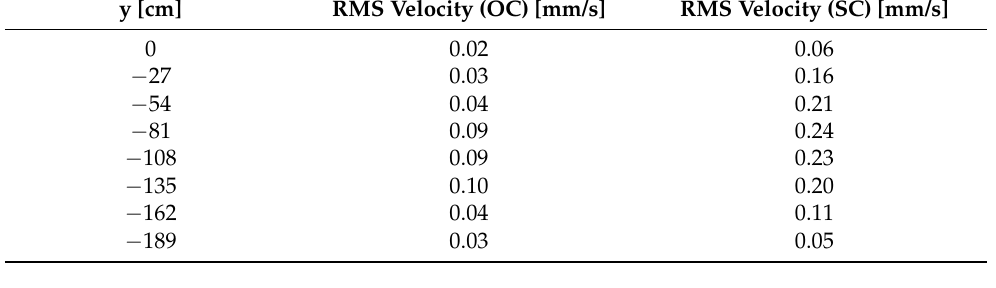
Figure 14. Visualization of the RMS values of the vibration velocity on the stiffener 2 from ( a ) the conservator side in the open-circuit test ( b ) the cooler side in the open-circuit test, and ( c ) the cooler side in the short-circuit test. Table 3. RMS values of the vibration velocity along the height on the stiffener 2 from the front side in the open-circuit (OC) and short-circuit (SC) test.